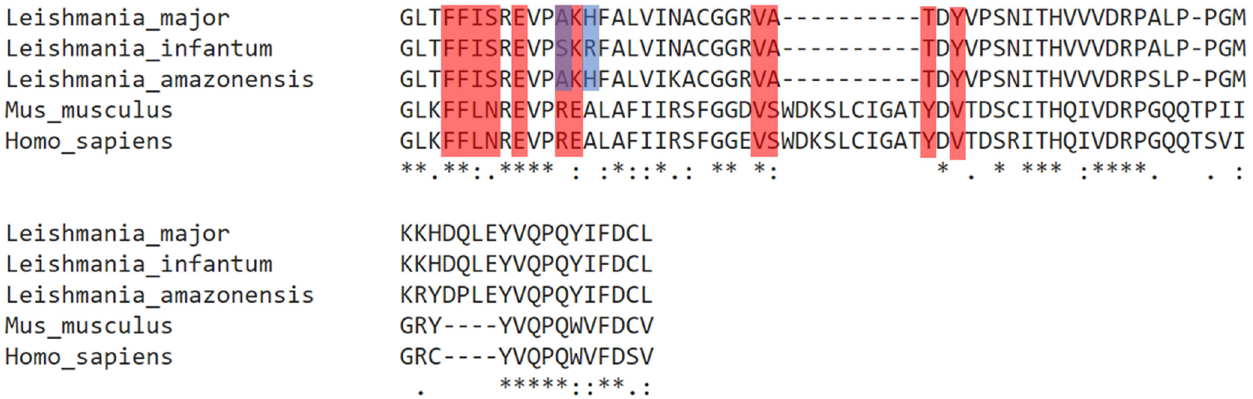
Figure 9. Multiple sequence alignments carried for Leishmania major (Lmj_04_BRCT) sequence and orthologues in L. infantum, L. amazonensis, Mus musculus , and Homo sapiens . Red: Important residues for CPE2–Mult1_lr interaction. Blue: Different residues between Lmj_04_BRCT domain protein sequences from L. major and its orthologue from L. infantum . An asterisk (*) represents positions which have a single, fully conserved residue. A colon (:) represents conservation between groups of highly similar properties. In contrast, a full stop (.) represents conservation between groups of weakly similar properties.